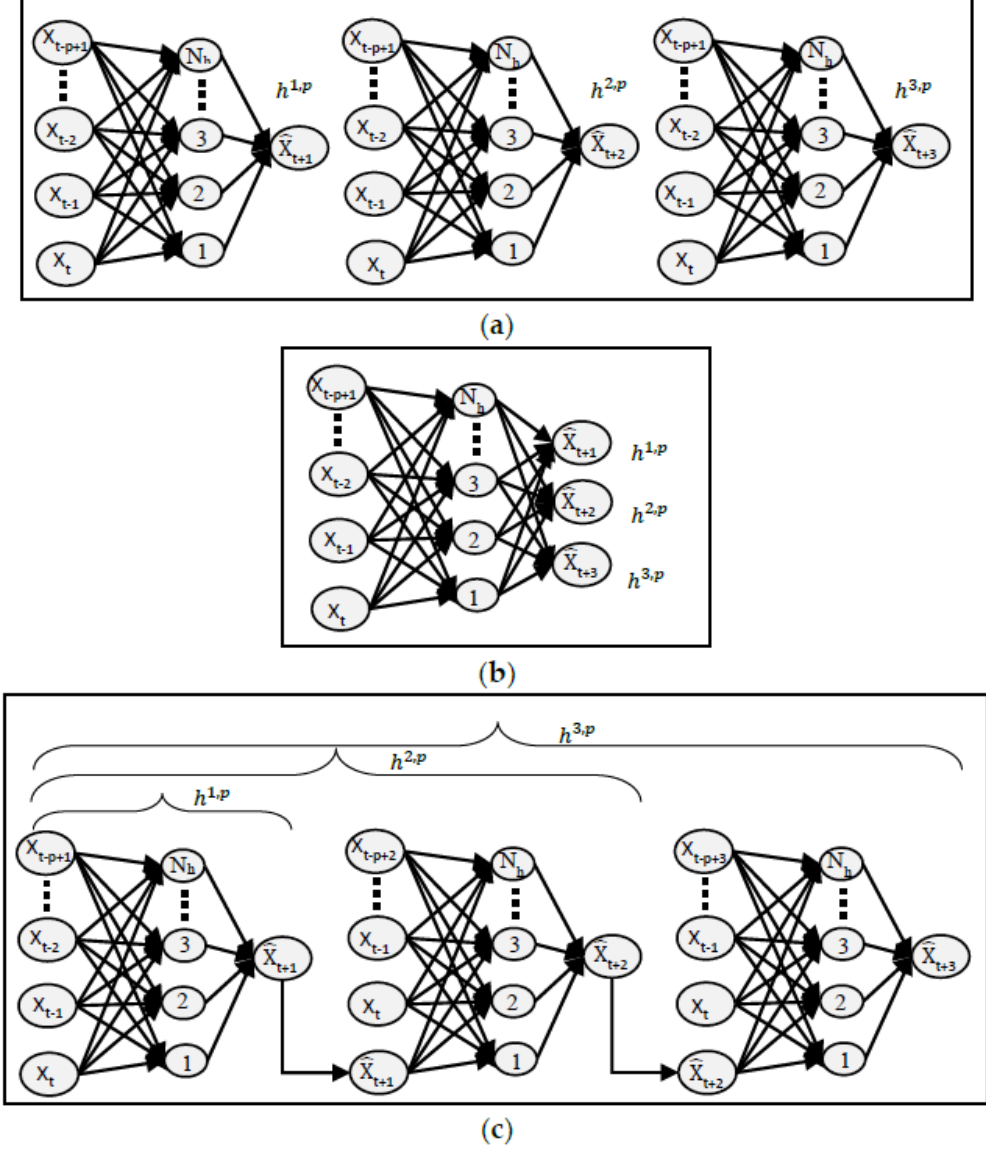
Figure 12. ( a ) MISO for three outputs; ( b ) MIMO with three outputs; ( c ) RNN model (unrolled) for three